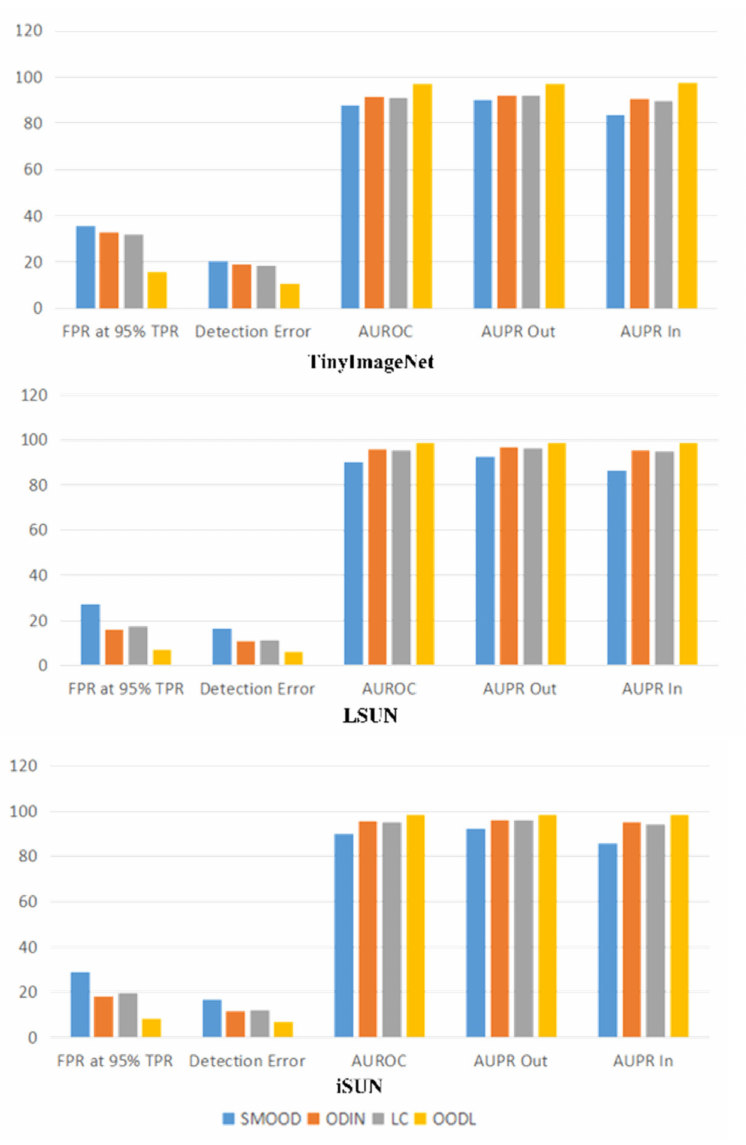
Figure 3. Comparison of results. The ID data are CIFAR-10, the OOD data are TinyImageNet, LSUN, and iSUN, and the model is